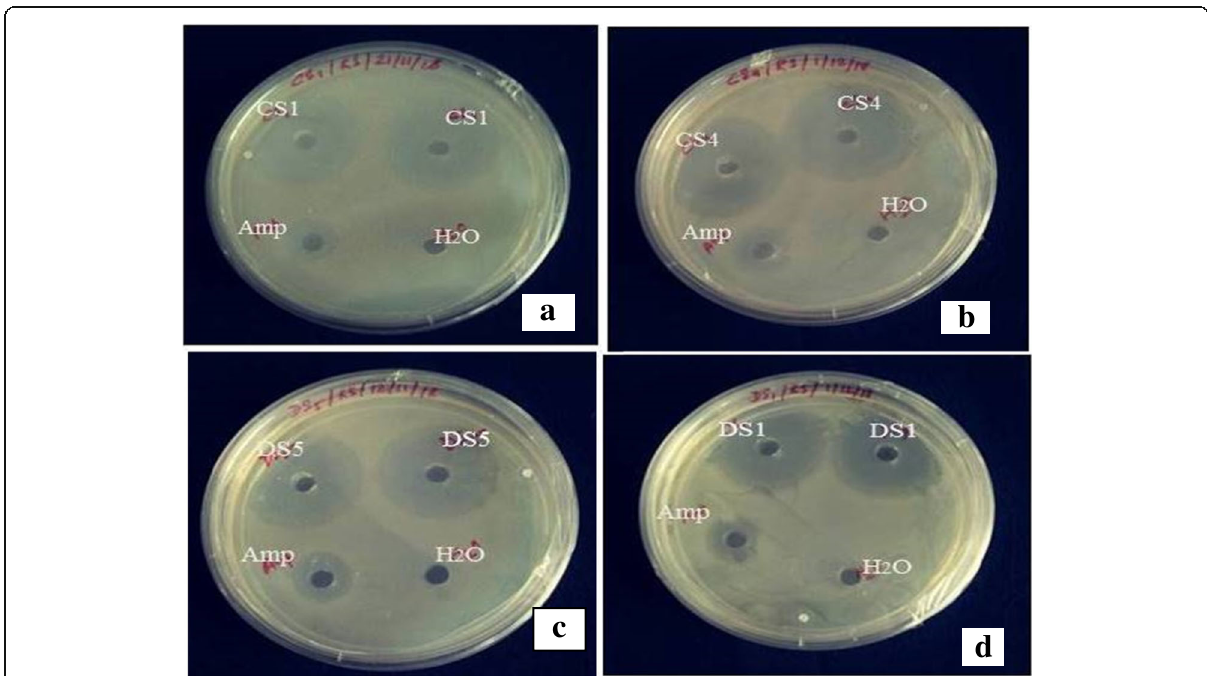
Fig. 2 Agar well diffusion assay of bacterial endophytes against plant pathogenic bacteria. a CS1 isolated from Chirata against bacterial pathogen ( X . oryzae ). b CS4 isolated from Chirata against bacterial pathogen ( R . solanacearum ). c DS5 isolated from Datura against bacterial pathogen ( X . oryzae ). d DS1 isolated from Datura against bacterial pathogen ( R . solanacearum )